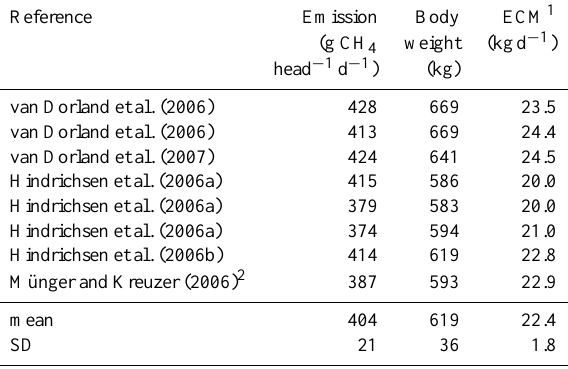
Table 3. Methane emissions from open-circuit respiration cham- ber measurements of Holstein and Swiss Brown breeds selected for milk yield and body weight comparable to cows in the present study. Hindrichsen et al. (2006a) used Swiss Brown breeds